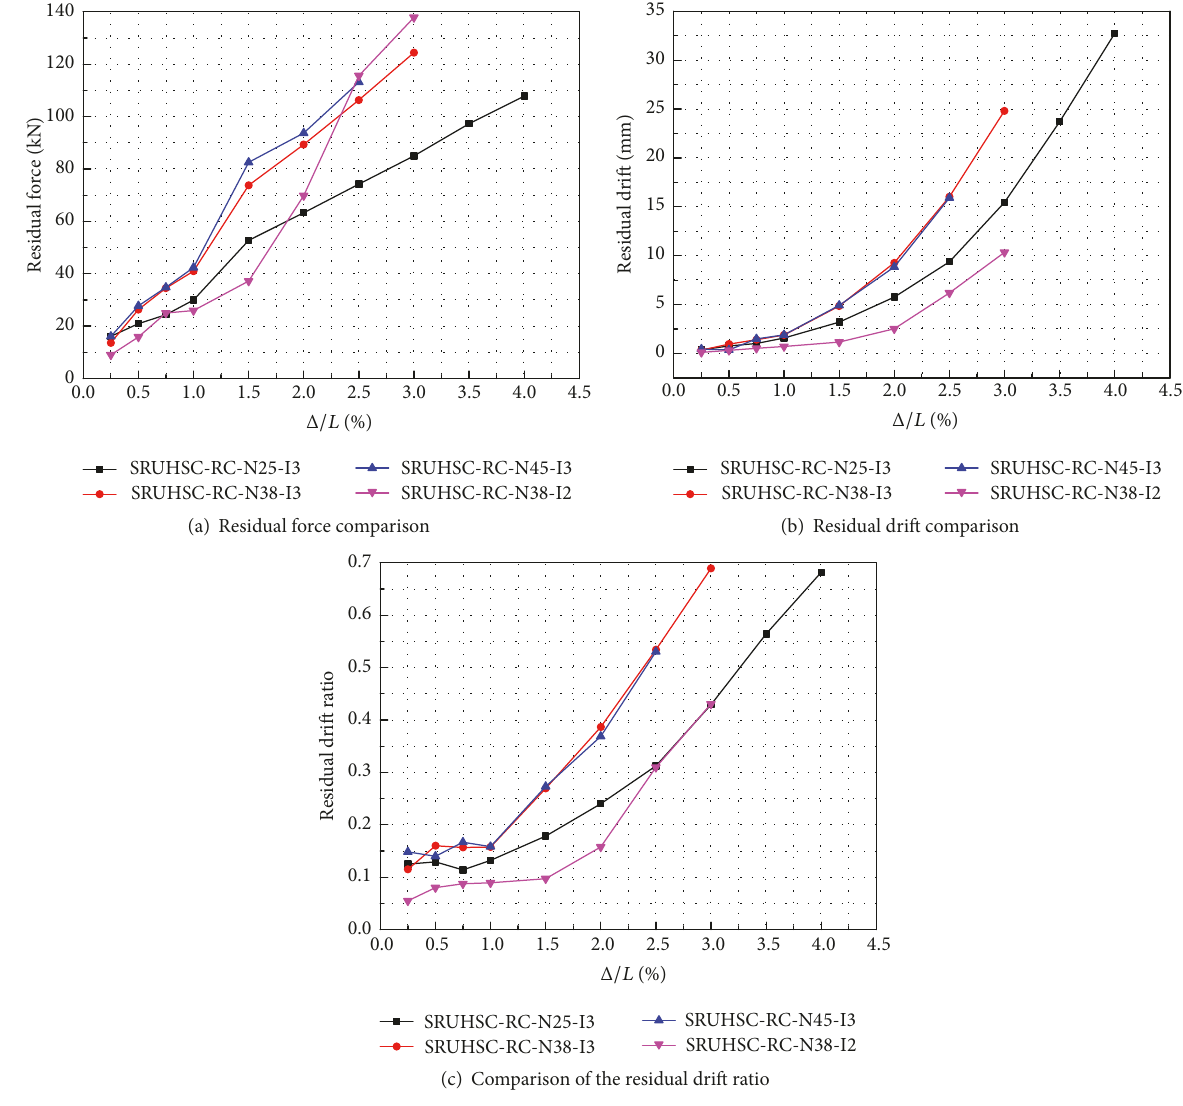
Figure 12: Comparison of the residual force and